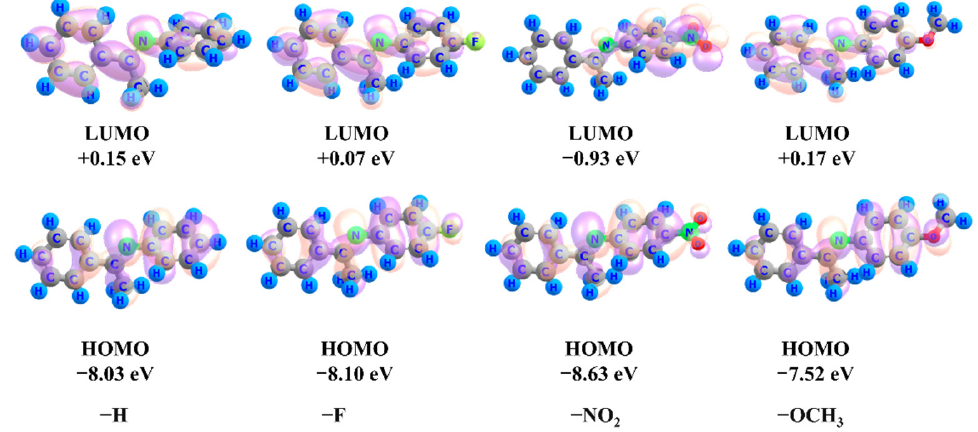
Figure 2. LUMO and HOMO orbitals of ( E )-imines with various substituents. Color code: C, grey; H, blue; O, red; N, green and F, light green.